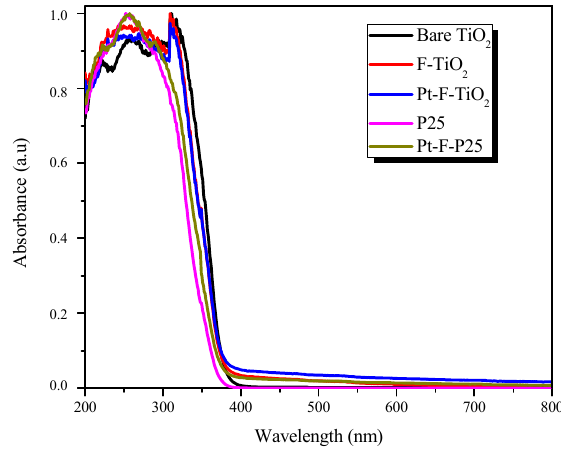
Figure 2. UV-Vis DR spectra for photocatalysts analyzed.